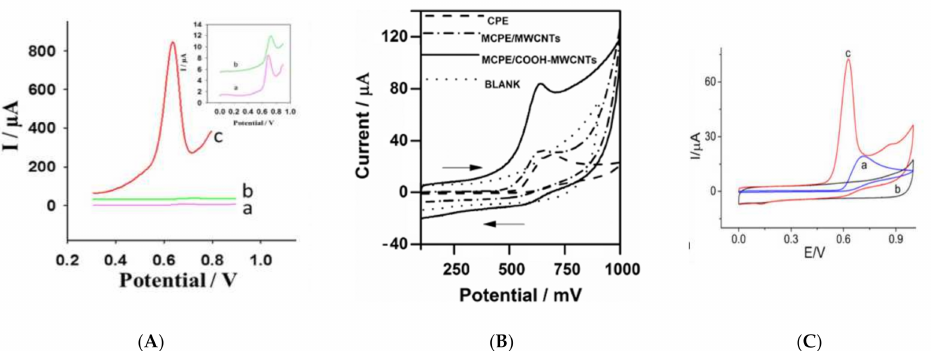
Figure 12. ( A ) SW voltammograms of 50 µ M Tyr in 0.1 M PBS (pH 6.7) on (a) bare GPE, (b)